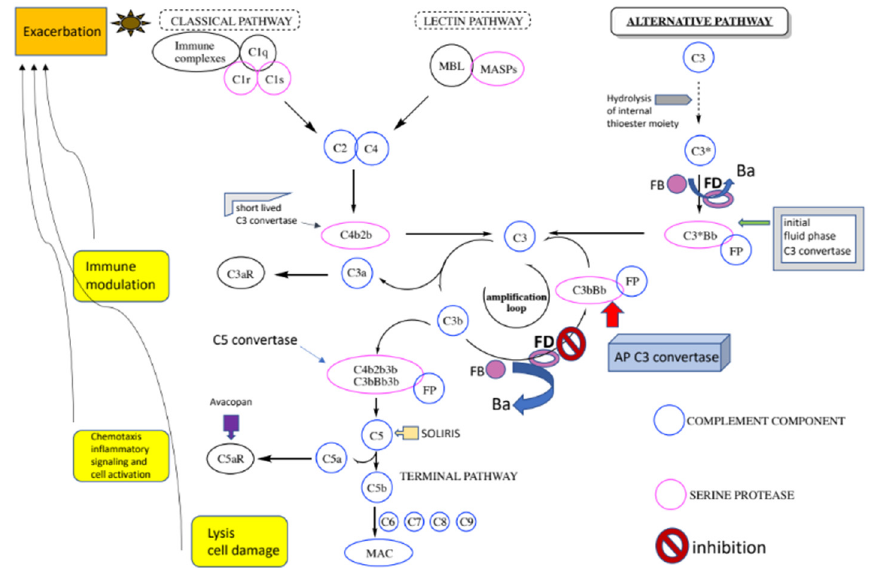
Figure 1. The complement system with a focus on the AP : A spontaneous hydrolysis of a thioester bond within C3 (C3 “tickover”) results in a conformationally altered C3 (designated C3 (H 2 O) or C3*) that makes the recruitment of FB possible. FB undergoes its own conformational change and is cleaved by another serine protease, factor D (FD), to generate fragments Ba and Bb. The latter contains the serine protease domain of FB and remains bound to the complex designated C3*Bb and the initial fluid phase AP C3 convertase. This convertase catalyzes the cleavage of C3 molecules to generate fragments C3a (anaphylatoxin) and C3b (opsonin). The same C3 proteolytic cleavage can also be catalyzed by the CP/LP C3 convertases, C4b2b. The released C3b components can enter into the critical amplification loop of the AP where complexes of foreign surface bound C3b and FB are similarly cleaved by FD to generate the predominant AP C3 convertases, C3bBb, on the targeted surfaces capable of additional C3 proteolytic cleavage. The C3b components also have the option of binding to either of the C3 convertases to form the respective C5 convertase complexes responsible for the breakdown of C5 molecules to release C5a and C5b. The latter interacts with C6, C7, C8, and C9 to form the membrane attack complex (MAC), which punctures the surface of some pathogens, resulting in subsequent cell lysis.